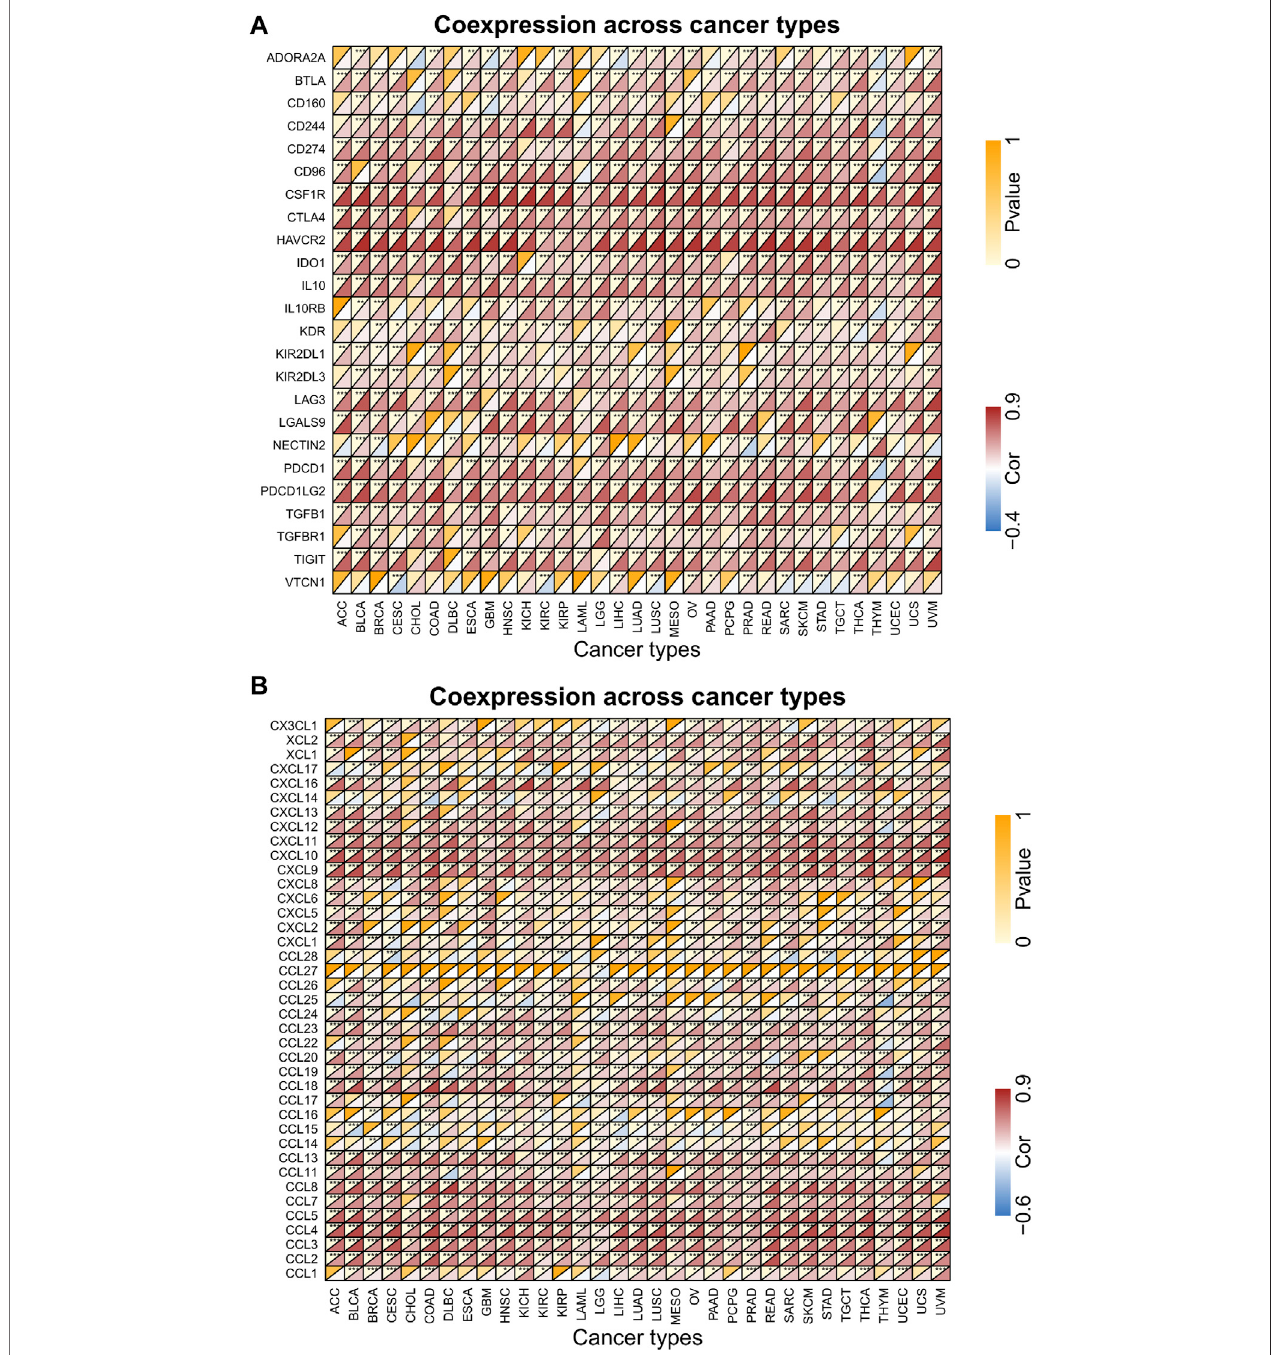
FIGURE5| Correlation analysisofFCGR3Aexpression withimmune-related genes. (A) immunosuppressiverelatedgenes; (B) chemokine genes.* p < 0.05; ** p < 0.01; *** p < 0.001.